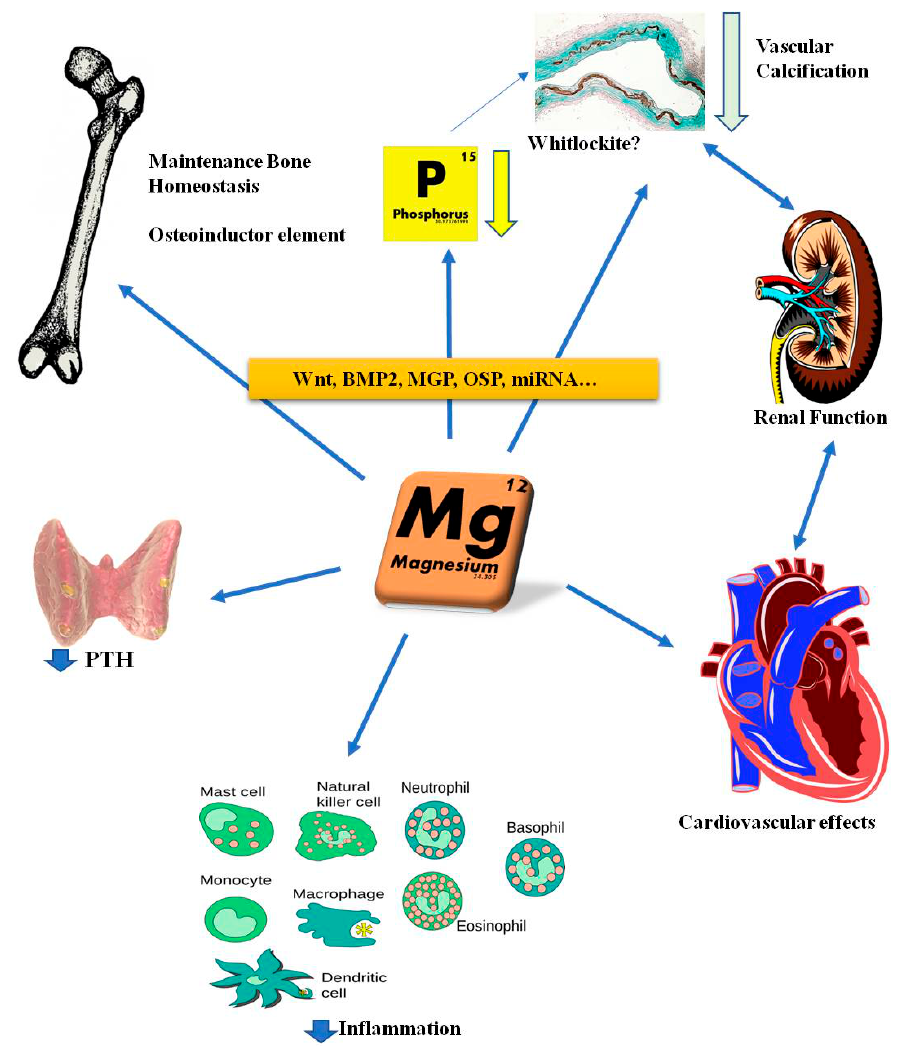
Figure 2. The pleiotropic effects of magnesium have been reported in several pathological conditions, showing beneficial effects at bone, renal and cardiovascular levels.